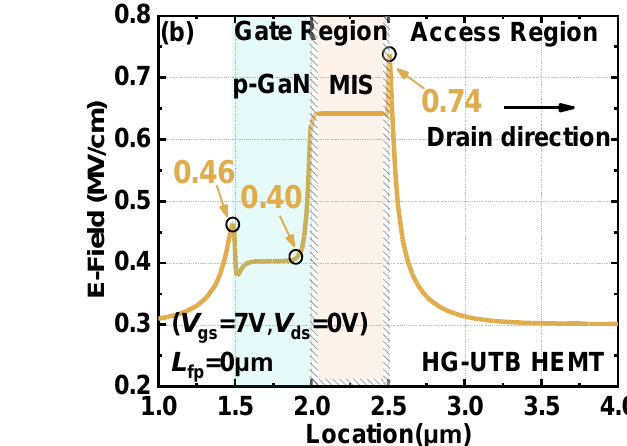
Figure 6. Distribution of the E-field beneath the gate region with gate bias of 7 V of ( a ) conventional p-GaN gate HEMTs and ( b ) HG-UTB HEMTs.